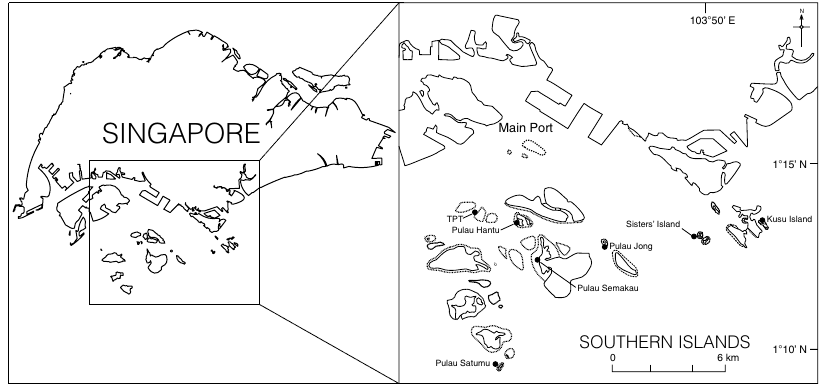
Figure 1. Map showing seven reefs in the southern islands of Singapore. Reefs organized from west to east: Terumbu Pempang Tengah (TPT), Pulau Satumu, Pulau Hantu, Pulau Semakau, Pulau Jong, Sisters’ Island and Kusu. Dotted lines represent fringing reef areas. The map is modified from Bauman et al . 37 and used